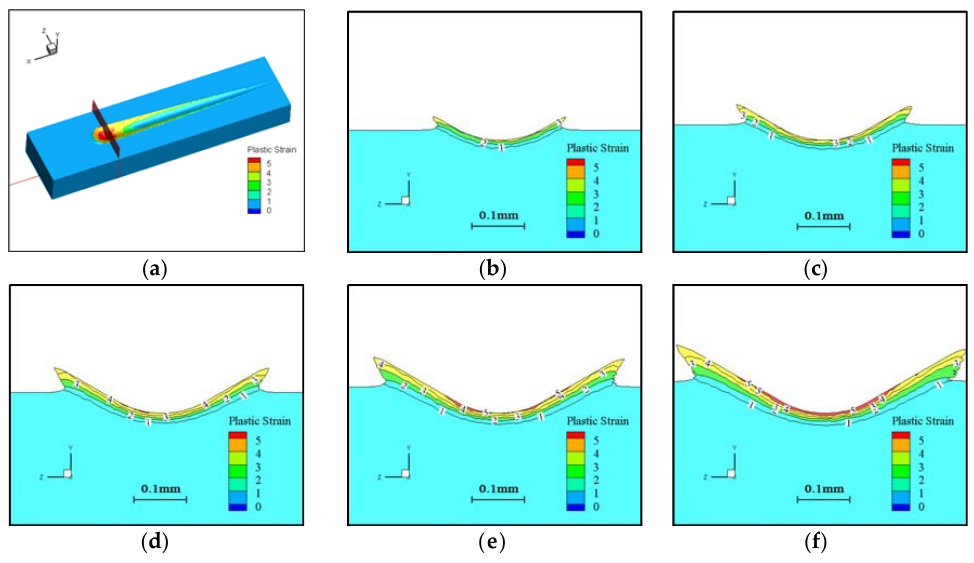
Figure 10. The plastic strain distribution along the scratch under different scratching lengths. ( a ) Plastic strain distribution along the scratch; ( b ) Length of scratch = 2 mm; ( c ) Length of scratch = 3 mm; ( d ) Length of scratch = 4 mm; ( e ) Length of scratch = 5 mm; ( f ) Length of scratch = 6 mm.